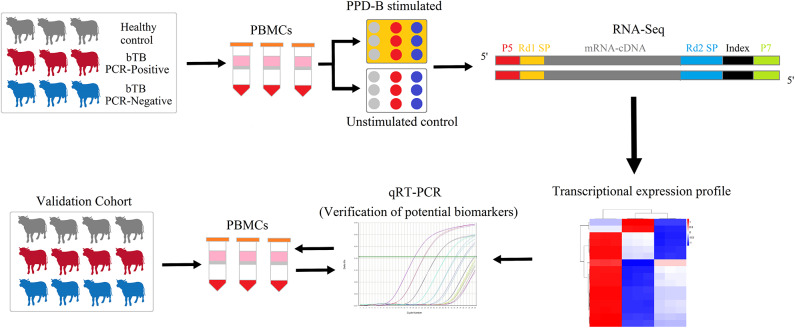
The experimental scheme of the study. Transcriptomes of PPD-B-stimulated and -unstimulated PBMCs from bTB PCR-P, bTB PCR-N, and HC cattle were profiled by RNA-Seq and then were analyzed by bioinformatic methods. Subsequently, the proposed potential biomarkers were validated by qRT-PCR in the validation cohort with 17 bTB PCR-P cattle, 17 bTB PCR-N cattle, and 17 HC cattle.